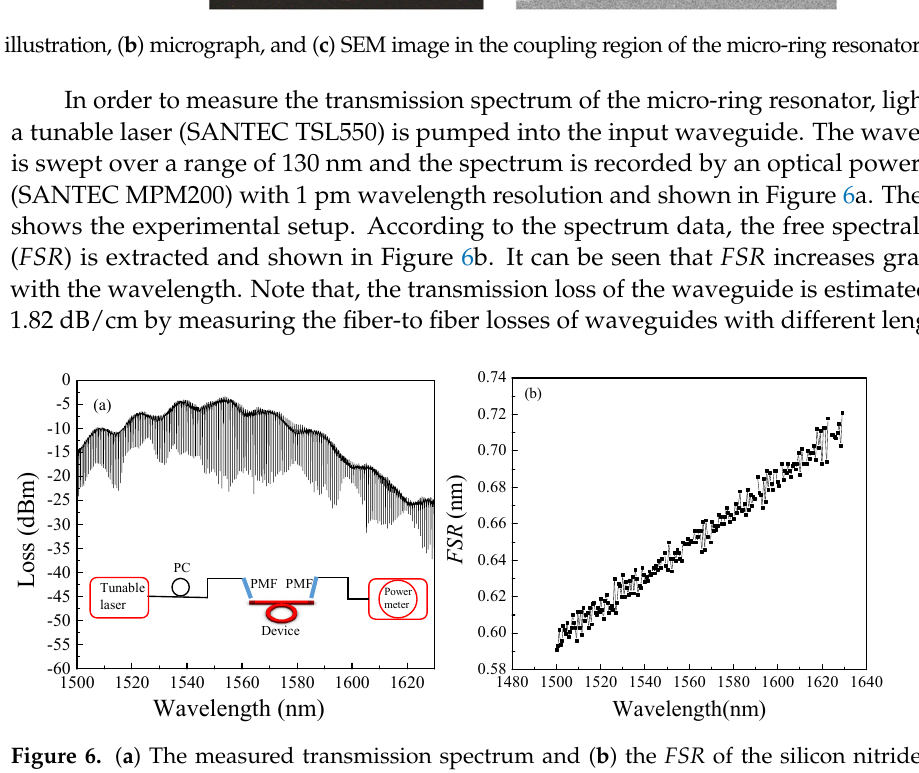
Figure 6. ( a ) The measured transmission spectrum and ( b ) the FSR of the silicon nitride micro-ring resonator. The insert is the experimental setup. PC: polarization controller, PMF: polarization maintain fiber.